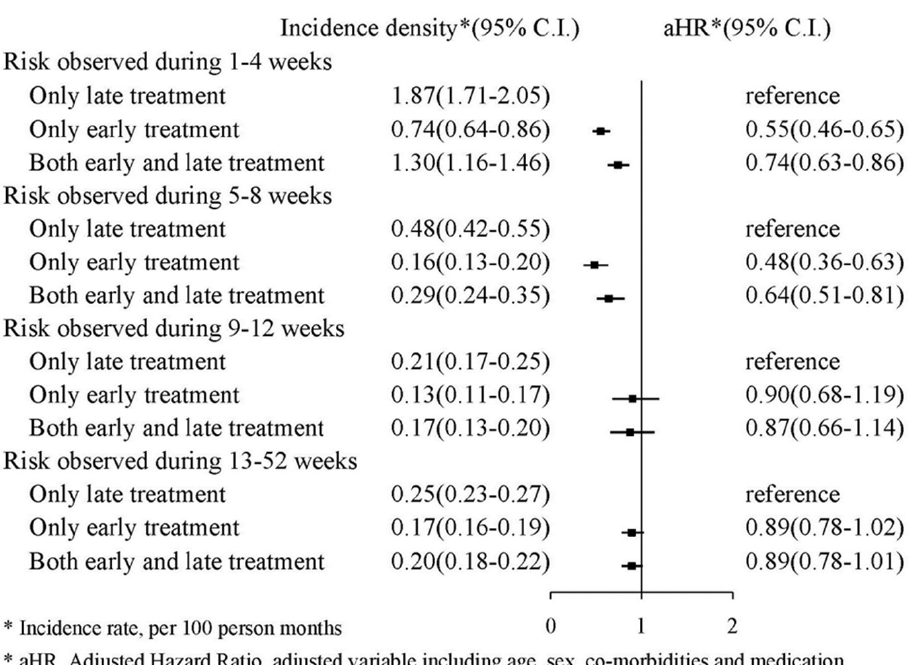
Figure 4. Incidence density of mortality.